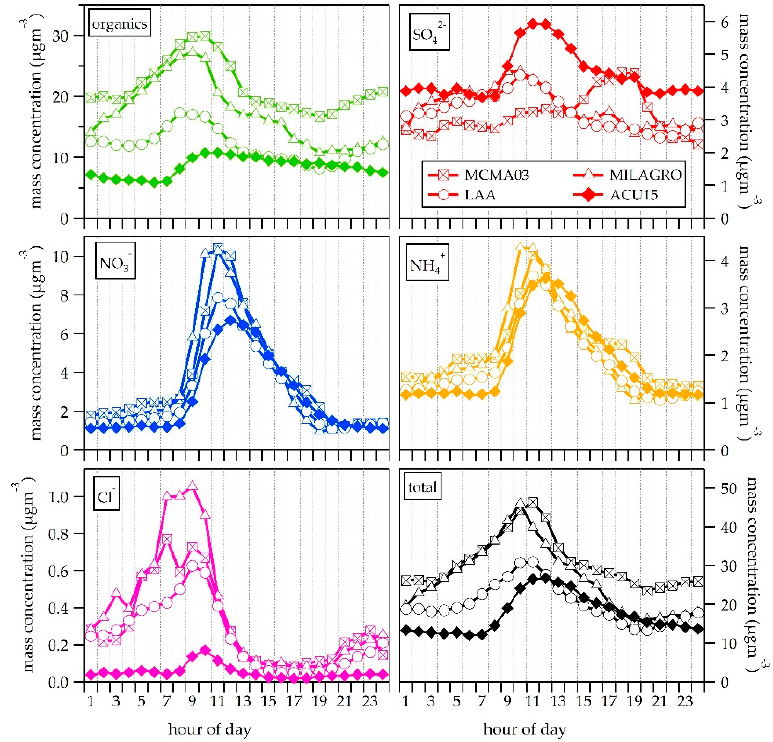
Figure 4. Average diurnal profiles of the mass concentration of the total NR-PM 1 and its component during ACU15 and previous studies in Mexico City involving an AMS [13,18,19]. AMS: Aerosol Mass Spectrometer.